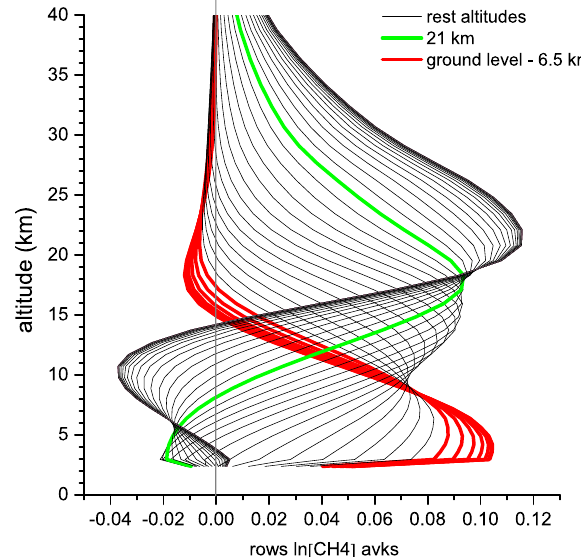
Fig. 4. Typical row averaging kernels for profiling retrieval (PR): red lines show the kernels between Iza˜na ground level and 6.5km, while the green line shows the kernel corresponding to an altitude of